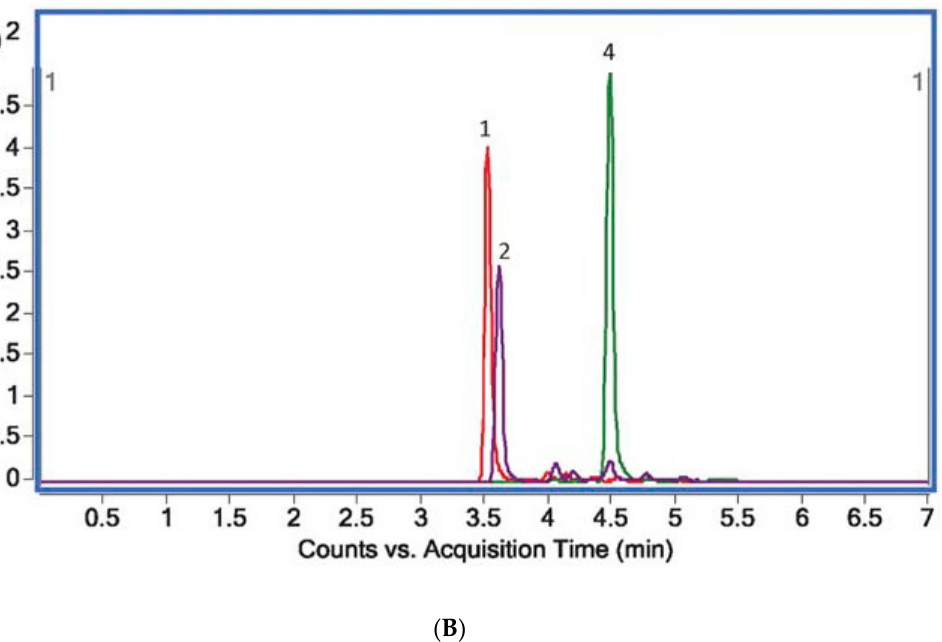
Figure 2. ( A ) Total ion MS chromatogram (TIC) showing standards of target alkaloids obtained with the use of UHPLC Q-TOF-MS: 1—protopine ( m / z = 353.7655), 2—sanguinarine ( m / z = 331.7065), 3—